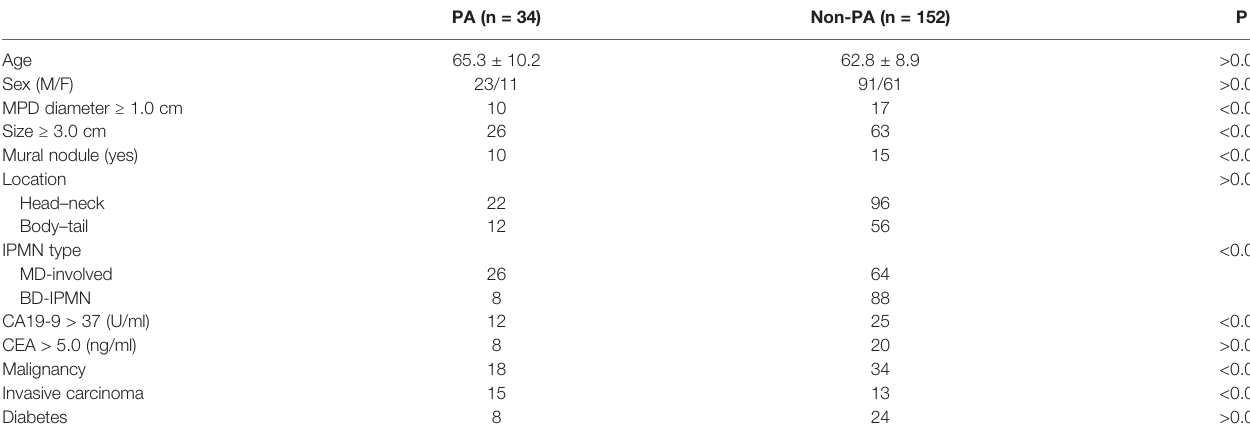
TABLE 1 | Characteristic of IPMN